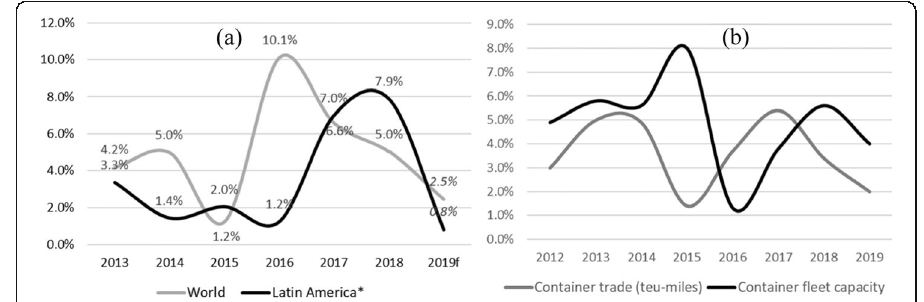
Fig. 3 Trade traffic volatility and overcapacity. Source: authors ’ elaboration